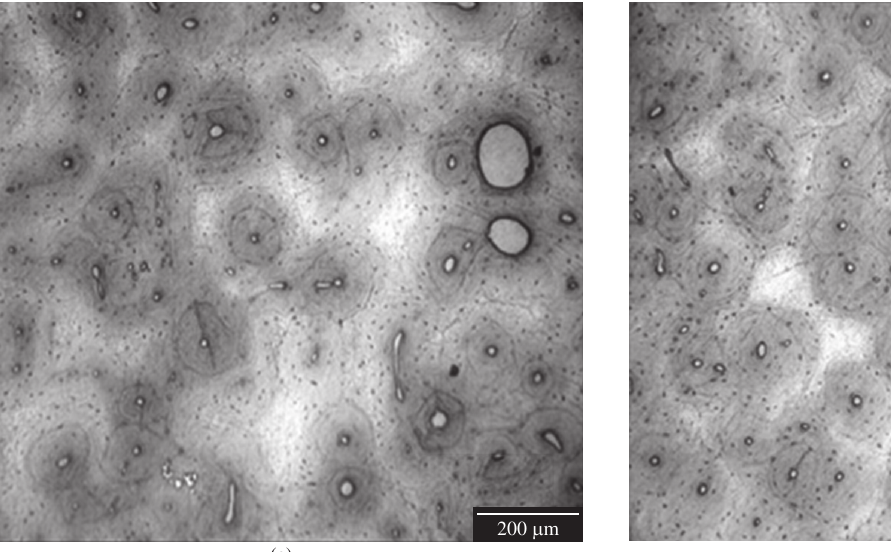
Figure 4. Optical micrographs: a) Composite center, and b) composite